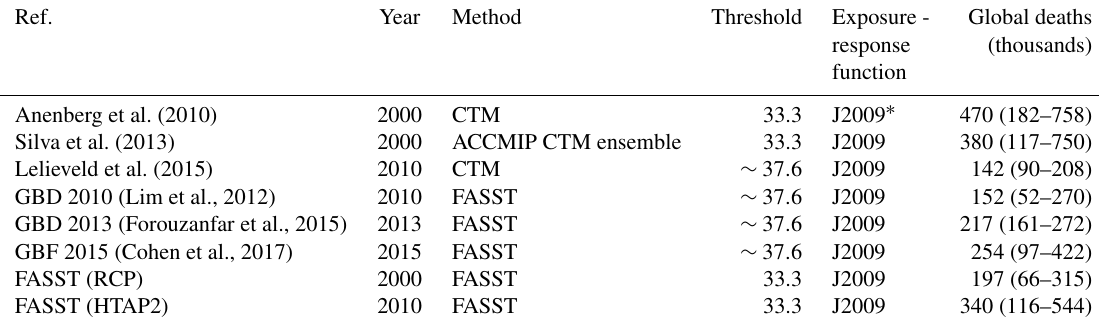
Table 15. Overview of previous studies on long-term health impact of ozone, together with FASST results for two different scenarios.